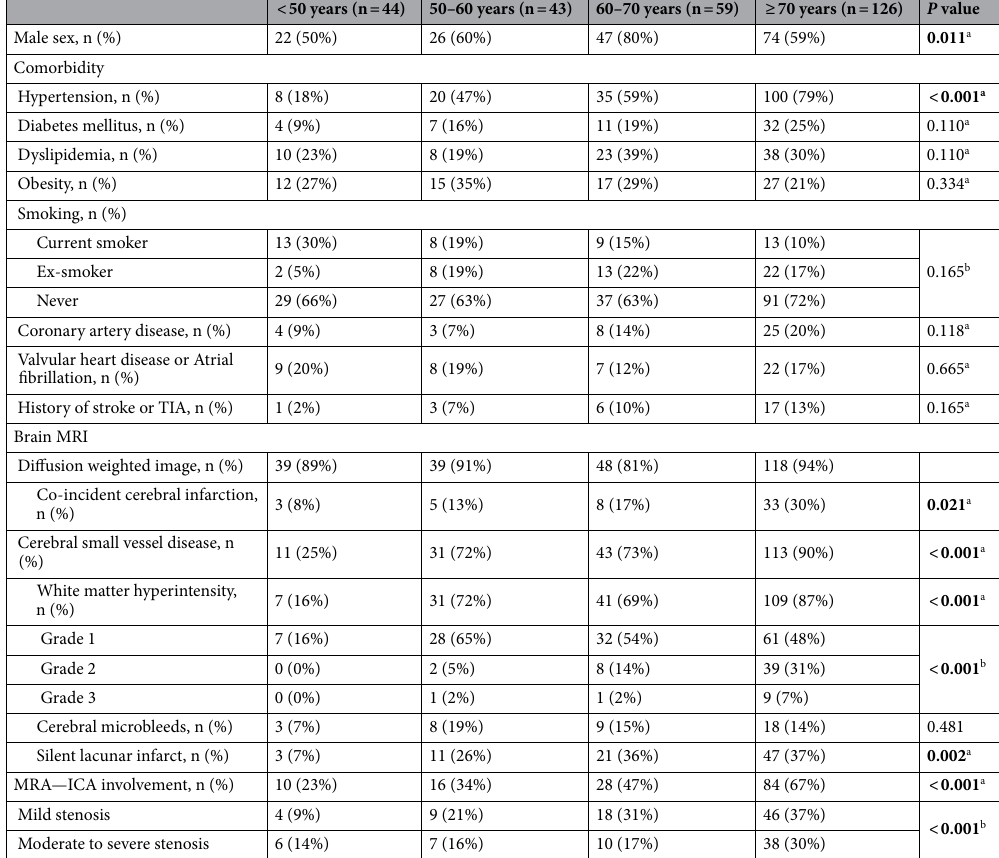
Table 3. Comparison of cerebral MRI findings between the age subgroups of < 50 years, 50–60 years, 60–70 years, and ≥ 70 years. Data are presented as number (%). P < 0.05 was deemed to